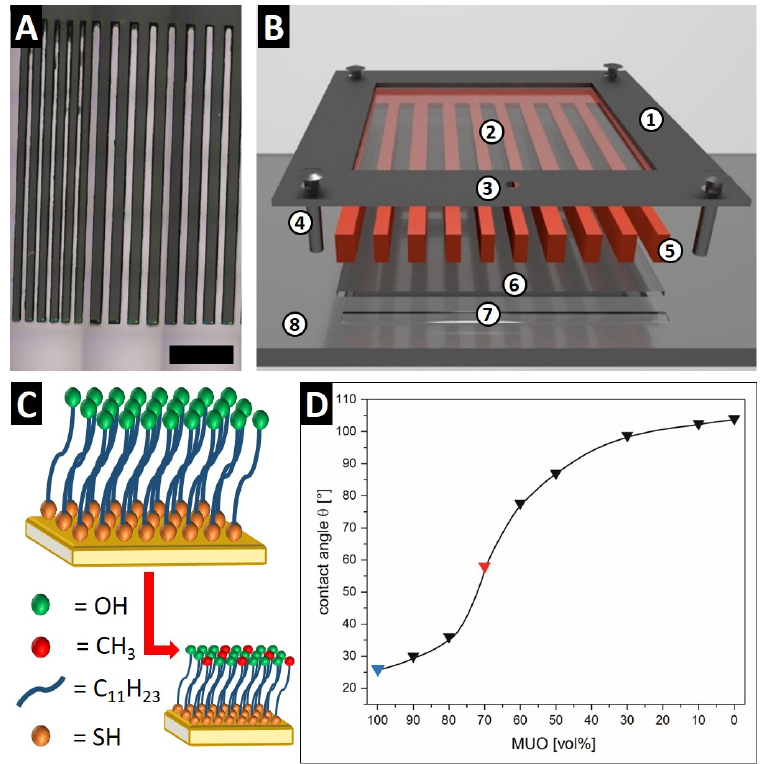
Figure 1. ( A ) LM image of a micro-comb test system (MCTS) (scale 1000 µm). ( B ) Schematic drawing of the infiltration setup with all compounds numbered: (1) metal frame; (2) top glass platelet; (3) inlet for solutions; (4) screws; (5) MCTS; (6) bottom glass platelet; (7) reservoir for infiltration solution; and (8) acrylic glass base plate. ( C ) Schematic image of a homogenous, hydroxyl-terminated self-assembled monolayer (SAM) on a gold surface (top) and a mixed SAM with 70% hydroxyl-terminated and 30% methyl-terminated thiols (bottom). ( D ) Contact angle measurements of SAM-modified, gold-coated substrates with different mixtures of MUO and DDT. The blue triangle symbolizes the pure MUO-SAM to mimic the wettability of PS. The red triangle symbolizes the thiol mixture 70/30 ( v / v ) to mimic the wettability of enamel and CM. The black line is the expected guideline for other mixtures.